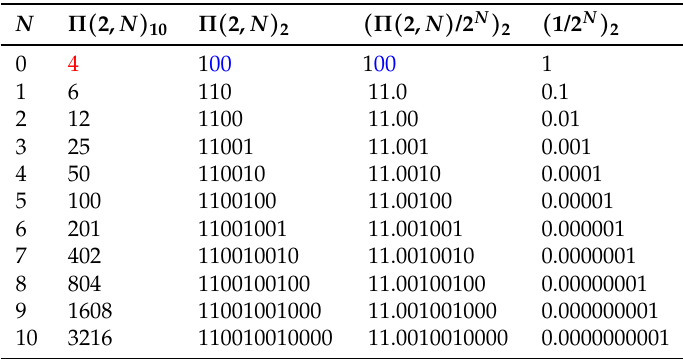
Table 3. Number of collisions Π given by Equation (13) for the ternary base, b = 3. The first column reports the value of mantissa N . The second column is the resulting number of collisions in the decimal base. The third column is the number of collisions written in the binary representation. The fourth column is the ternary representation of the number π with N digits in the fractional part. The fifth column gives the systematic error according to Equation (55). The case where approximation (14) fails as compared to (13) is highlighted by red. The blue digits are incorrectly predicted by the Galperin billiard. N Π ( 3, N ) 10 Π ( 3, N ) 3 ( Π ( 3, N ) /3 N ) 3 ( 1/3 N ) 3 0 4 11 11 100 10.0 0.1